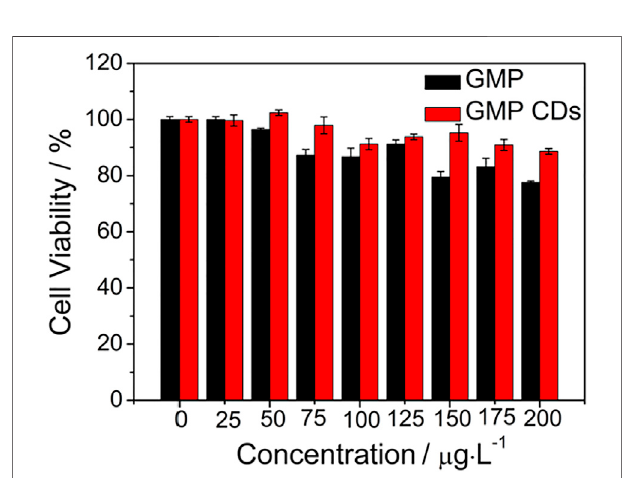
FIGURE 6 | Viability of HeLa cells treated with N/P CDs at various concentrations (0 – 200 μ g · mL − 1 ) for 24 h.